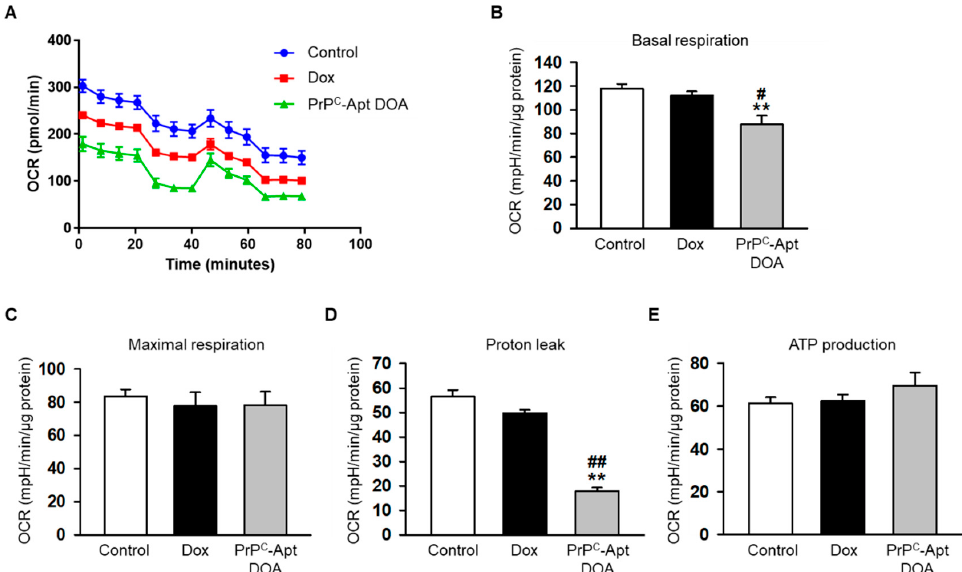
Figure 5. PrP C -Apt DOA inhibit mitochondrial function of CRC cells to a greater degree, as compared to free Dox. ( A ) Mitochondrial oxygen consumption rates (OCRs) of SNU-C5 cells treated with free Dox or PrP C -Apt DOA were measured over time (min). The cells were treated with oligomycin (1 µ M, 20 min), FCCP (0.75 µ M, 40 min), and antimycin A (1 µ M, 60 min) to obtain bioenergetic parameters. ( B ) Basal respiration was measured by subtracting non-mitochondrial OCR (which is the remaining OCR post antimycin A treatment) from the initial OCR level. ( C ) Maximal respiration was measured upon addition of FCCP. ( D ) Proton leak was calculated by subtracting the OCR post antimycin A treatment from the OCR post oligomycin A treatment. ( E ) Adenosine triphosphate (ATP) production was determined by subtracting non-mitochondrial OCR from the OCR value of basal respiration. The histogram shows representative data from one replicate experiment ( n = 5). The values represent mean ± SEM. ** p < 0.01 vs. control; # p < 0.05, ## p < 0.01 vs. free